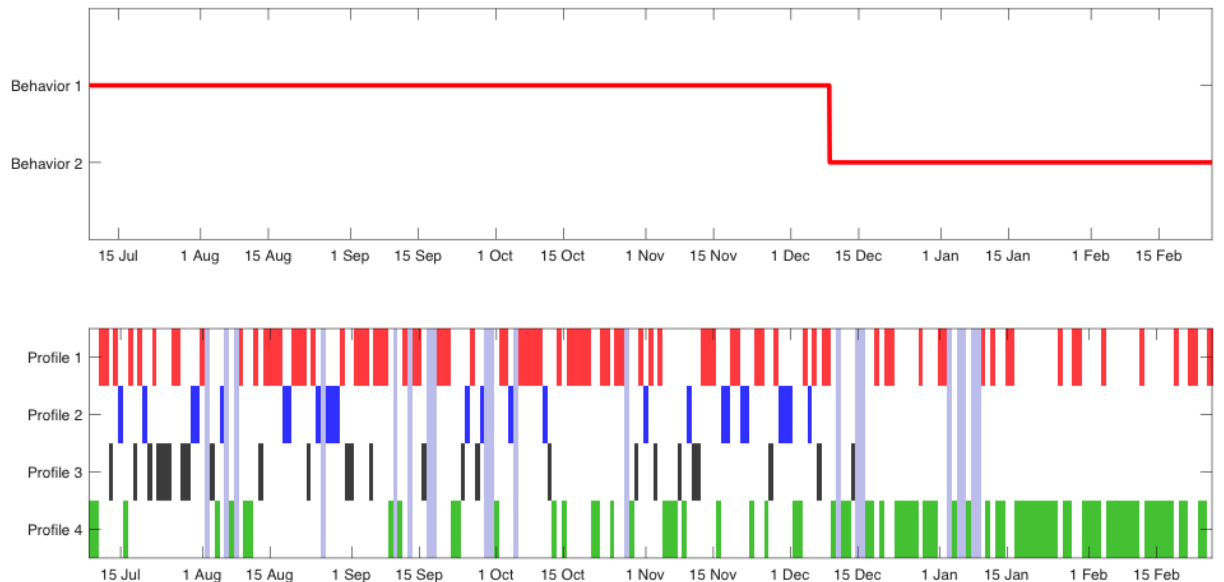
Figure 8. Representation of mobility pattern changes (above) identified by the technique and corresponding patterns (down) during study participation of patient